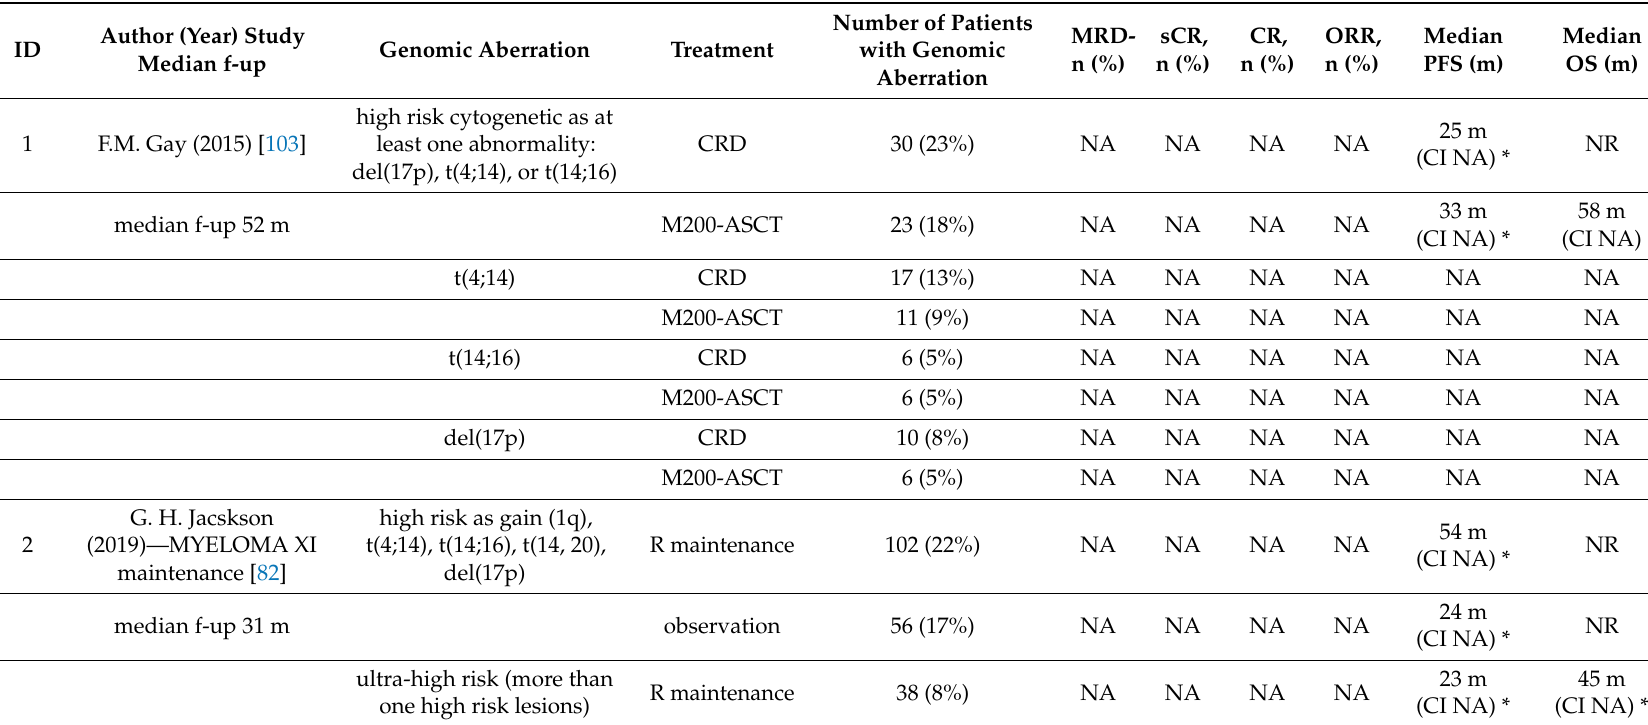
Table 3. Outcomes in transplant eligible patients with MM that were treated at diagnosis in large phase 3 trials according their genome aberrations. On 21 November 2020, we searched on PubMed (multiple myeloma AND phase 3 NOT relapse * NOT resist *) AND Clinical Trial[ptyp] AND “last 5 years”[PDat] and we received 39 results; these results were manually curated and all the trials including transplant eligible patients from diagnosis and presenting evaluable randomized data on prognostic impact of genomic aberrations in MM are included in this table. M = melphalan, V = bortezomib, P = prednisone, Dara = daratumumab, R = lenalidomide, D = dexamethasone, C = cyclophosphamide, T = talidomide, ASCT = autologous stem cell transplant, NA = not available, sCR = stringent complete response, CR = complete remission or better, MRD- = negative measurable residual disease, NR = not reached, CI = confidence interval, f-up = follow-up, * = statistically significant between study arms in sub-cohort analysis. Descriptive sentence or number of events with median follow-up are reported whenever median PFS and / or OS are not reported for the study. Some digit may vary from the original report due to